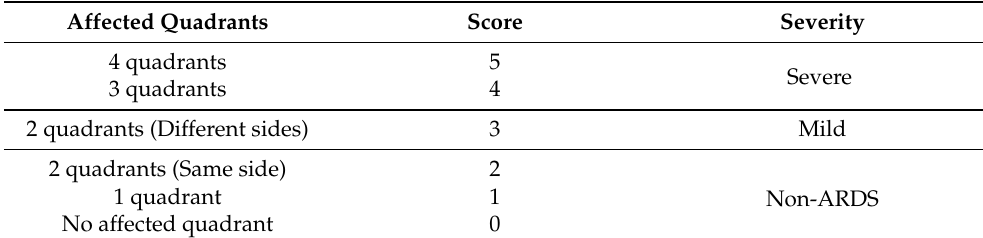
Table 2. Severity scoring scheme based on affected lung